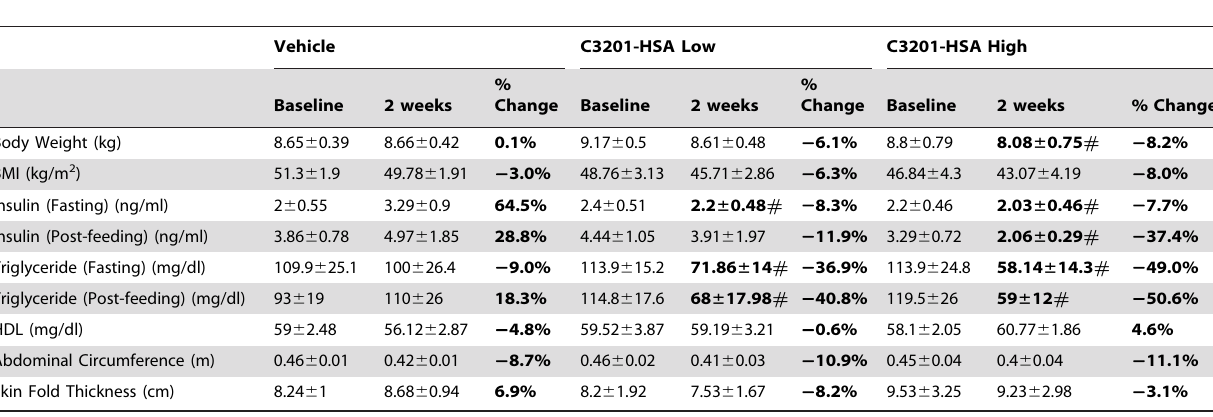
Table 4. PD parameters at baseline and 2 weeks after first administration of low and high doses of C3201-HSA and vehicle.